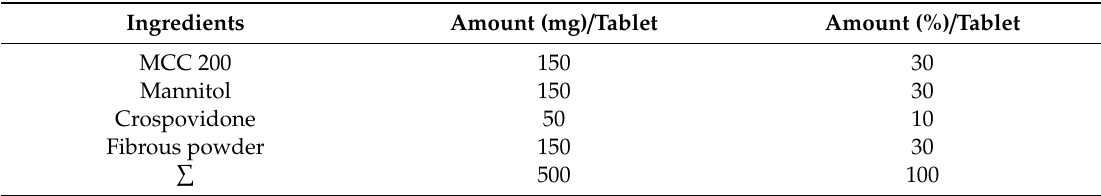
Table 2. Composition of the produced